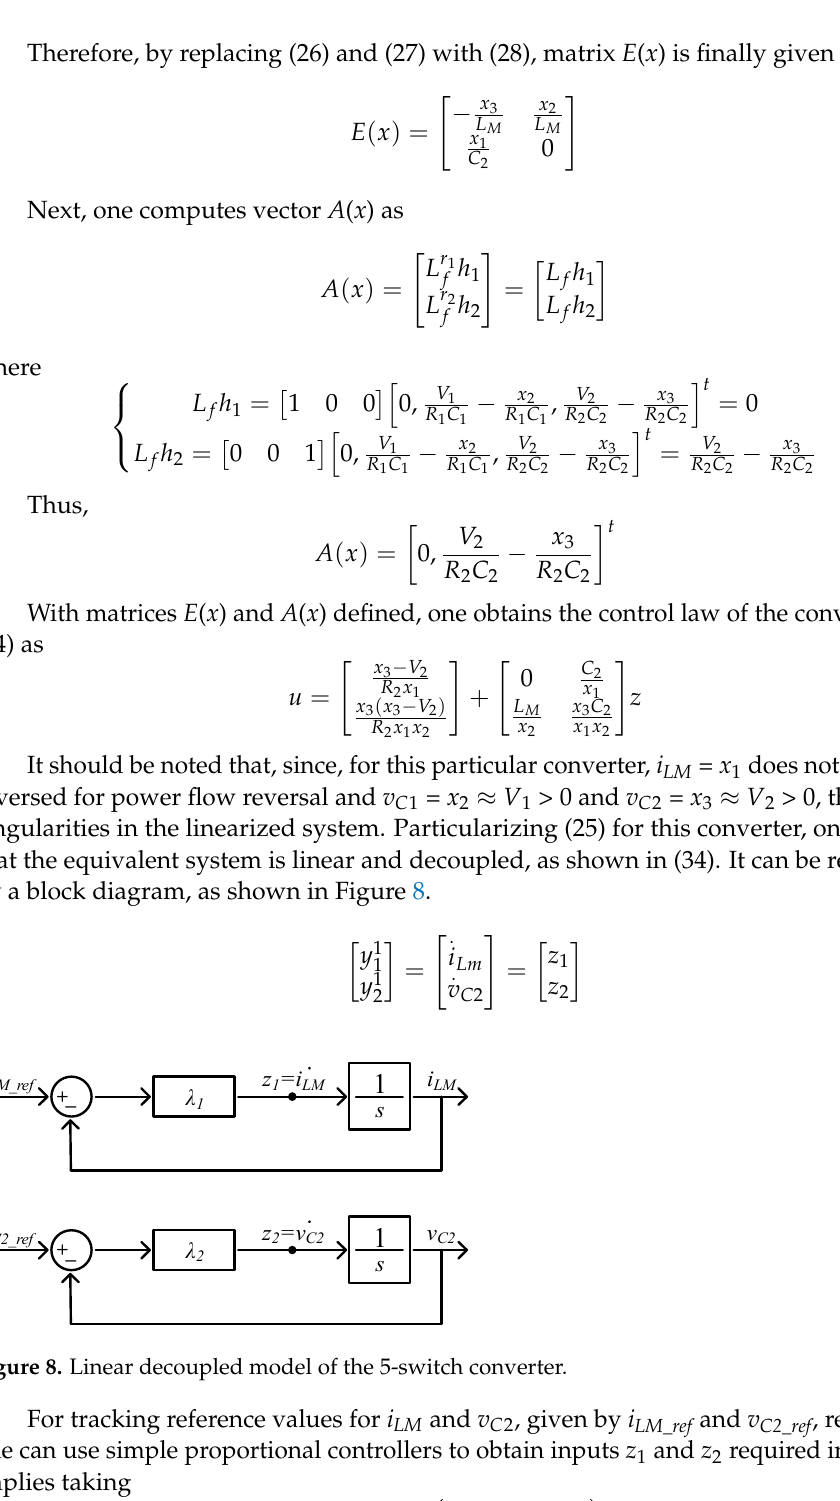
Figure 9. Model of the DIDO system with the state feedback linearization network and simple P- type controllers.